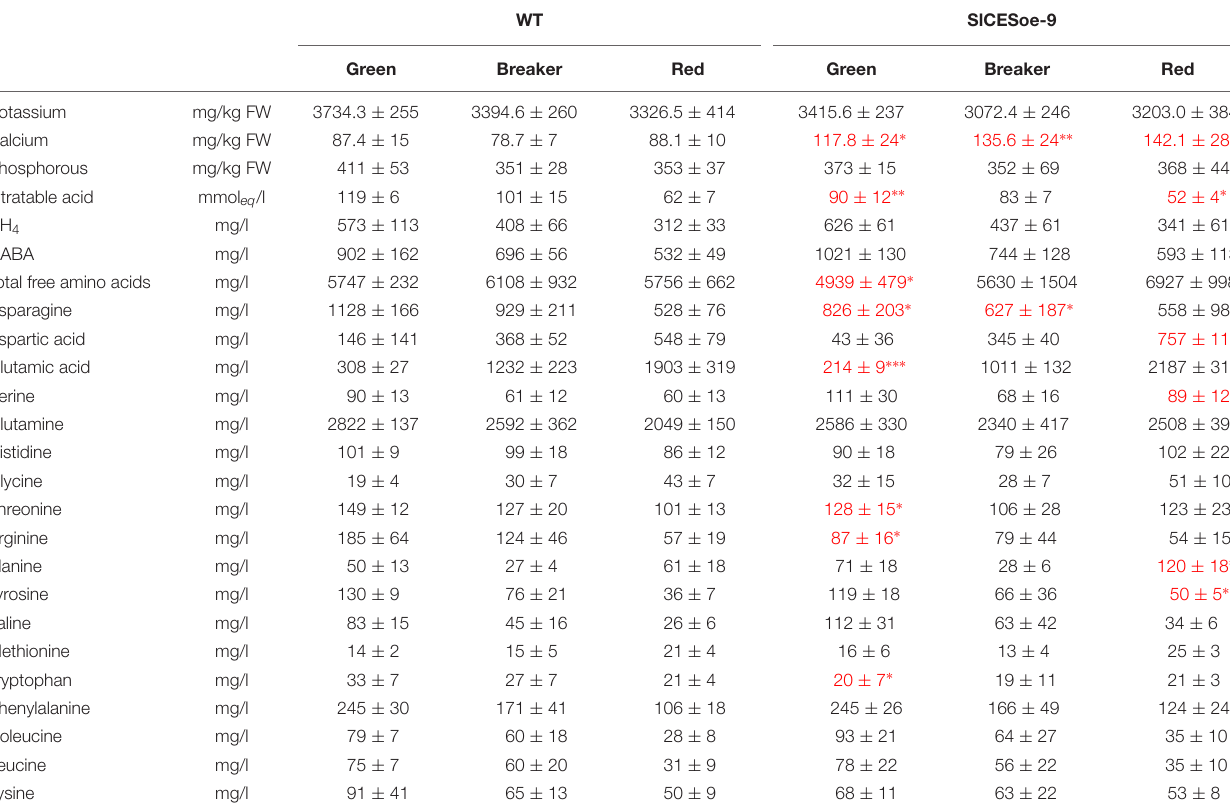
TABLE 1 | Concentration of relevant minerals and amino acids in fruits of SlCESoe-9 and wild-type plants at the green, breaker, and ripe stages. WT SlCESoe-9 Green Breaker Red